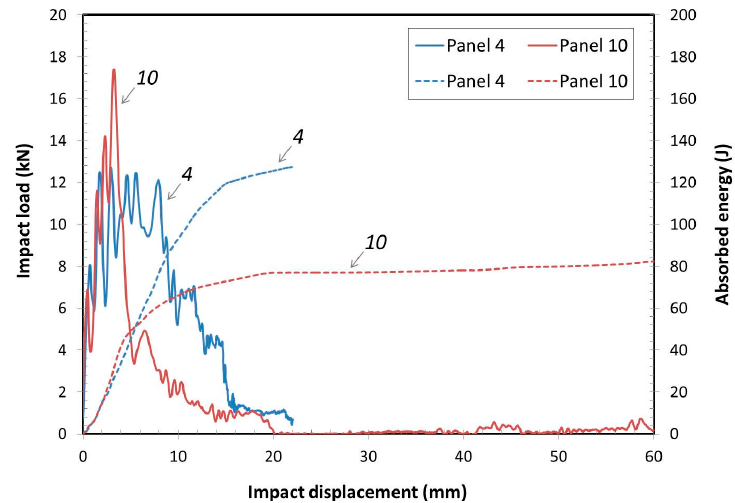
Figure 8. Impact load and absorbed energy vs. impact displacement for the panels with different core sizes.